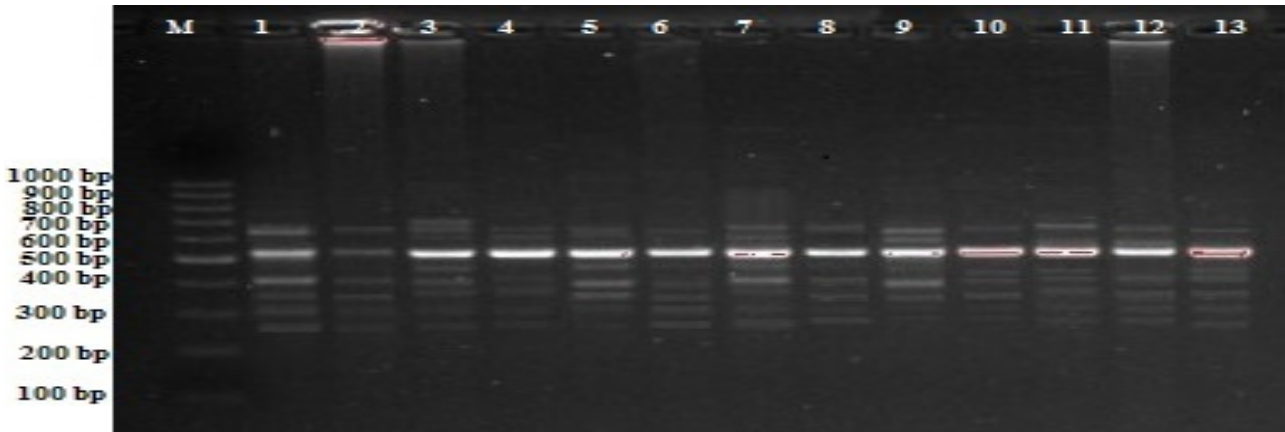
Figure 1. iPBS profiles for various experimental groups with 2075 primers in bean M; 100–1000 bp DNA ladder, 1; control (MS without any hormone) 2; MS medium containing 10 − 8 mM 17 ‐β‐ estradiol, 3; MS medium containing 10 − 6 mM 17 ‐β‐ estradiol, 4; MS medium containing 10 − 4 mM 17 ‐β‐ estradiol, 5; MS medium containing 10 − 8 mM progesterone, 6; MS medium containing 10 − 6 mM progesterone, 7; MS medium containing 10 4 mM progesterone, 8; MS medium containing 10 − 8 mM testosterone, 9; MS medium containing 10 − 6 mM testosterone, 10; MS medium containing 10 − 4 mM testosterone, 11; MS medium containing 10 − 8 mM estrogen, 12; MS medium containing 10 − 6 mM estrogen, 13; MS medium containing 10 − 4 mM estrogen.